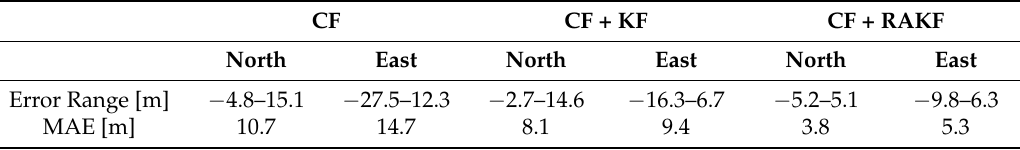
Table 2. Error comparison table in walking under different heading estimation algorithm. CF: complementary filtering; KF: Kalman filter.